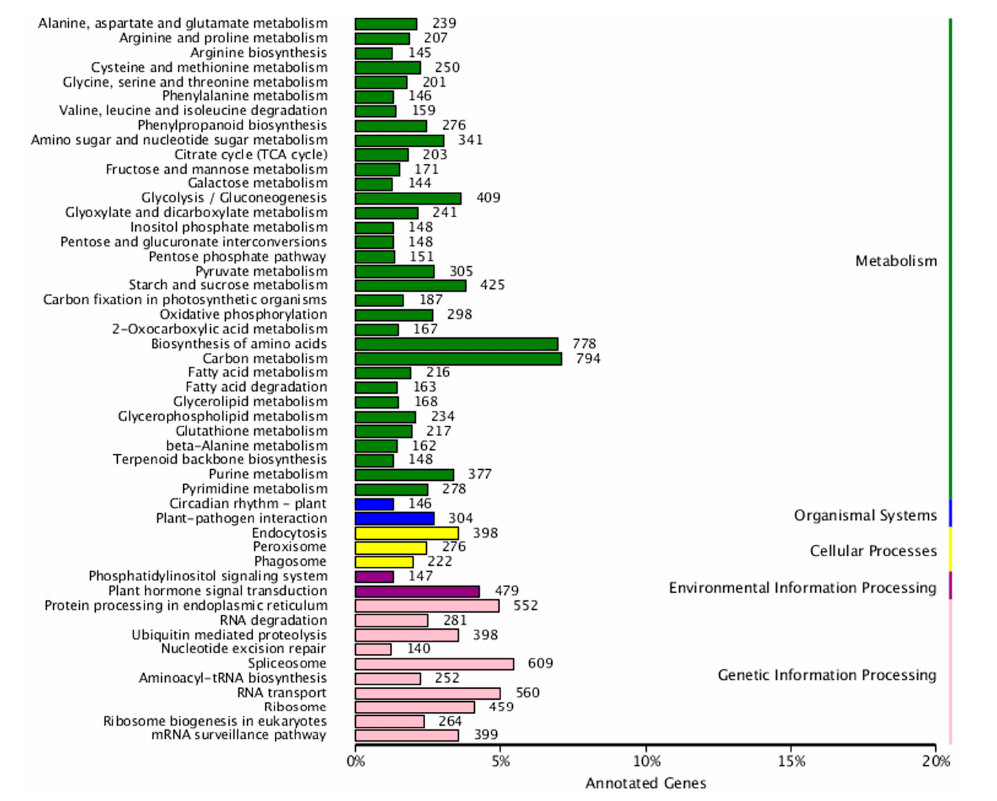
Figure 9. KEGG pathway classification diagram of N. sibirica